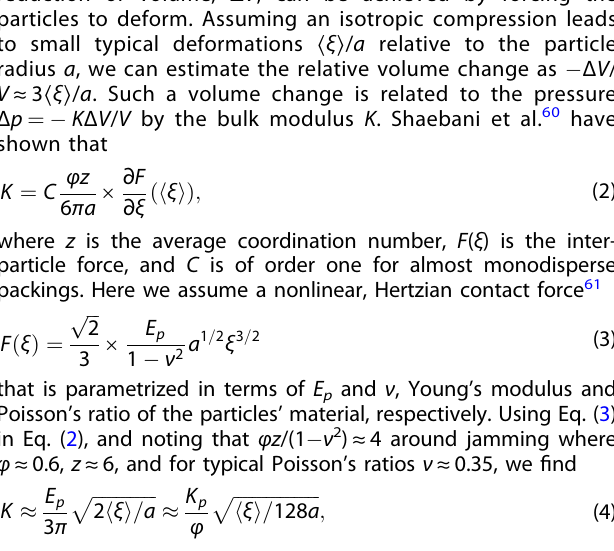
Fig. 9 Pressure p exp measured on the bottom sensor inside an experimental cell fi lled with powder but with no motion of the piston. Pressure changes are solely due to changes in acceleration during parabolic fl ight maneuvers. The offset pressures found from . the microgravity phases are shown as dashed lines, labeled p a ; b ; c ; d ; e 0 The increase in offset pressure throughout the experiments shown here is clearly visible, amounting to + 0.34 kPa in 1000